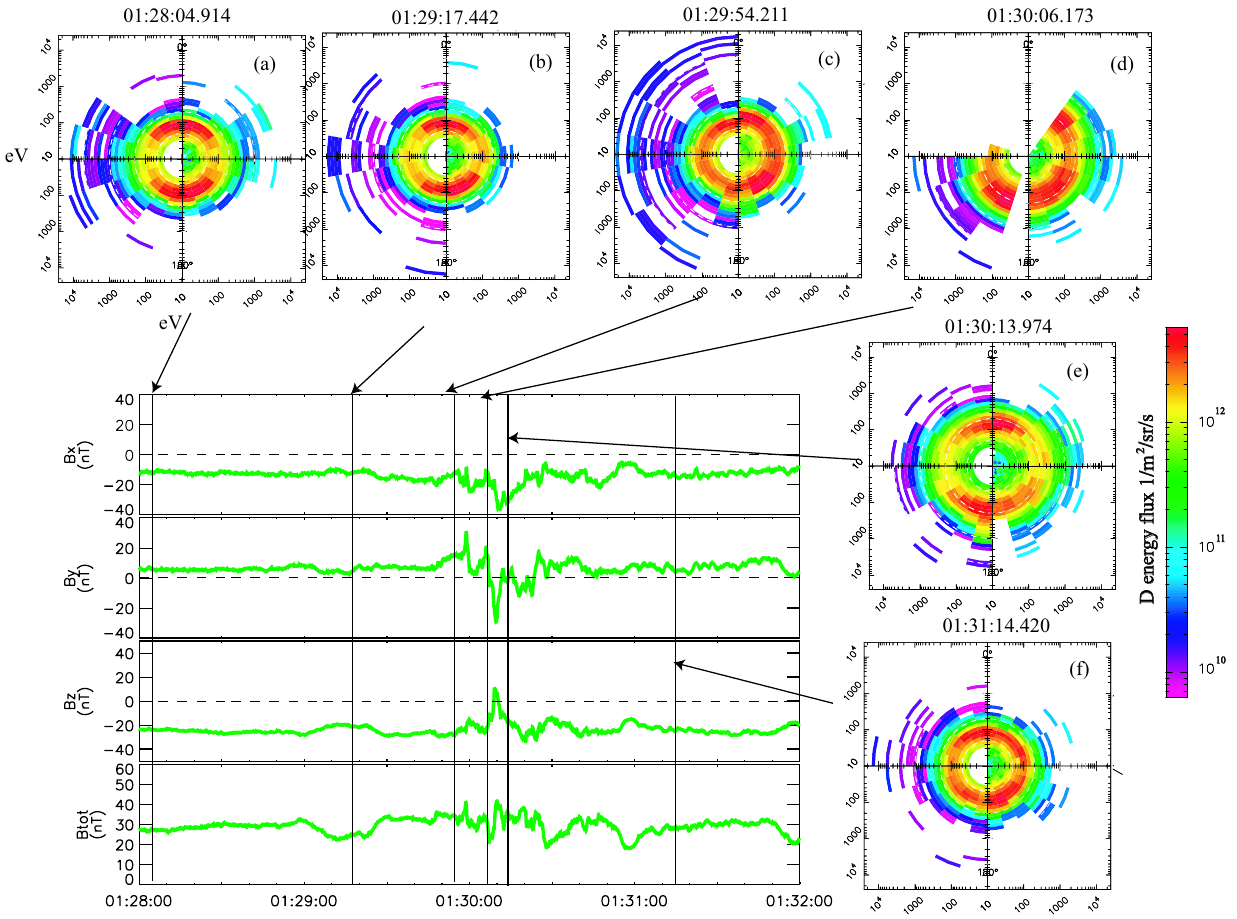
Fig. 10. Electron velocity distribution obtained from PEACE during an interval of the first type boundary crossing. Also shown is the magnetic field data during the interval. The timing of the distributions is indicated in the